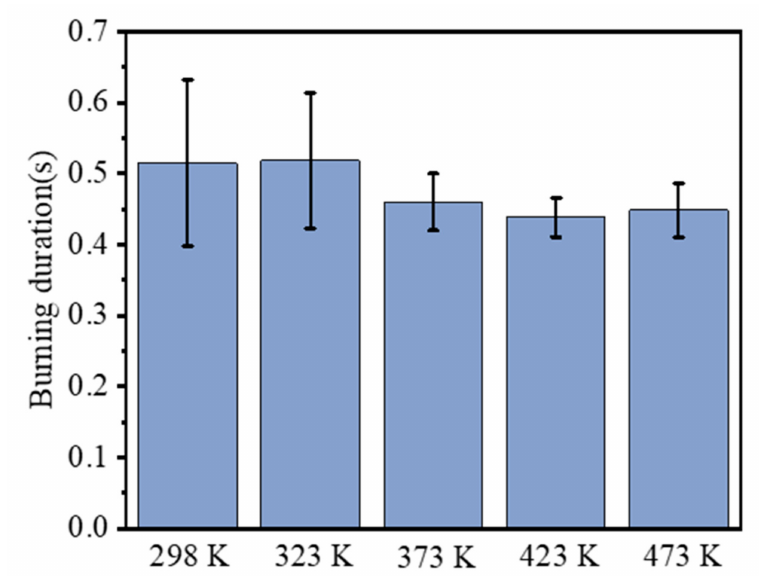
Figure 7. Comparison of combustion duration at different initial temperatures.